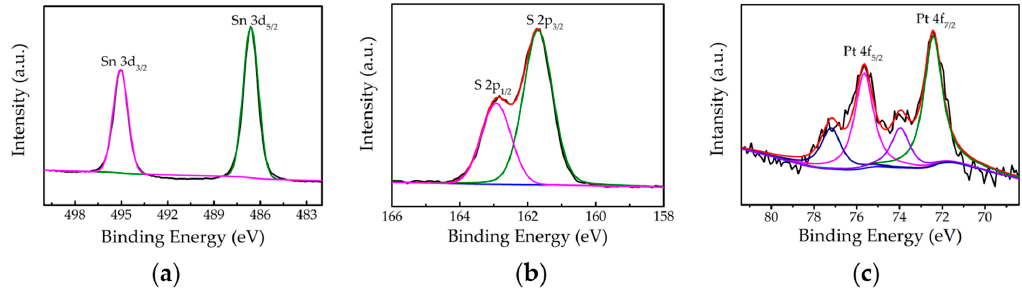
Figure 3. Chemical state analysis of SnS 2 -Pt-3. ( a , b ) are Sn 3d and S 2p high-resolution XPS spectra